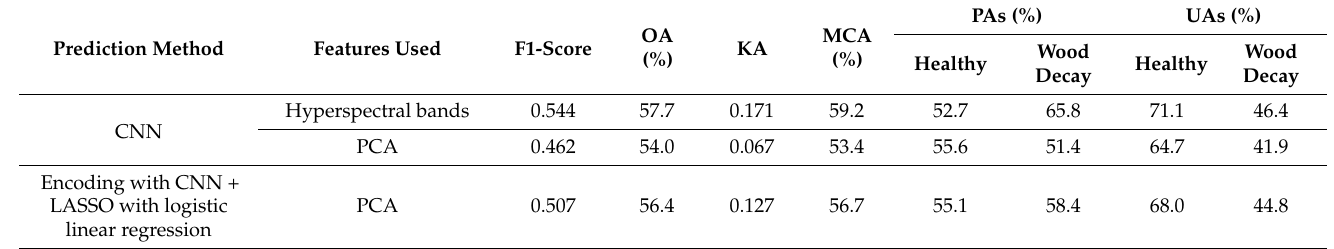
Table 7. Overall summary of the model performances with un-aggregated pixels for Dataset II.